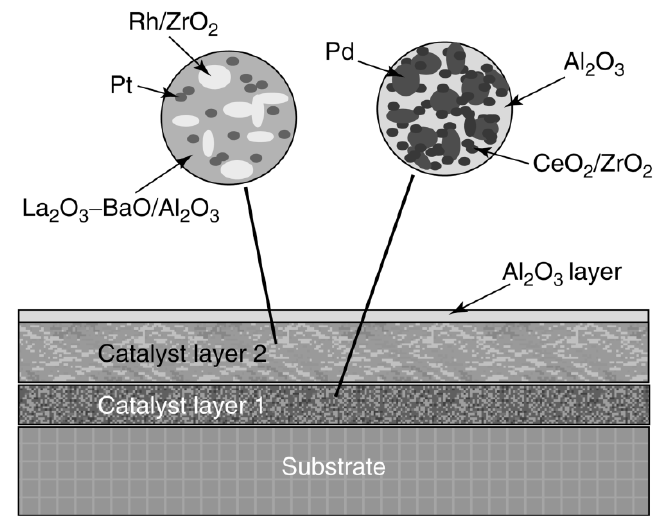
Figure 34. Conceptual design (by C. H. Bartholomew) of an advanced three-way catalyst for auto emissions control. Catalyst layer 1 is wash-coated first onto the monolithic substrate and consists of ( a ) well-dispersed Pd, which serves to oxidize CO/hydrocarbons and to reduce NO and ( b ) CeO 2 /ZrO 2 crystallites (in intimate contact with Pd), which store/release oxygen respectively, thereby improving the performance of the Pd. Catalyst layer 2 (added as a second wash coat) is a particle composite of Rh/ZrO 2 (for NO reduction) and Pt/La 2 O 3 –BaO/Al 2 O 3 (with high to moderately-high activity for oxidation of CO and hydrocarbons). A thin (50–80 μm) coat of Al 2 O 3 , deposited over catalyst layer 2, acts as a diffusion barrier to foulants and/or poisons. Both the Al 2 O 3 layer and catalyst layer 2 protect the sulfur-sensitive components of catalyst layer 1 from poisoning by SO 2